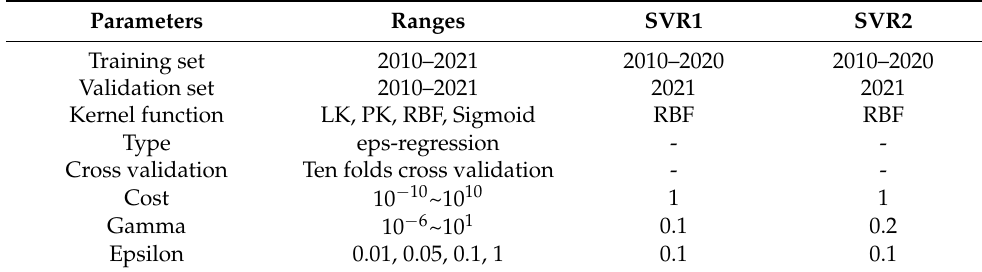
Table 4. Support vector regression parameter